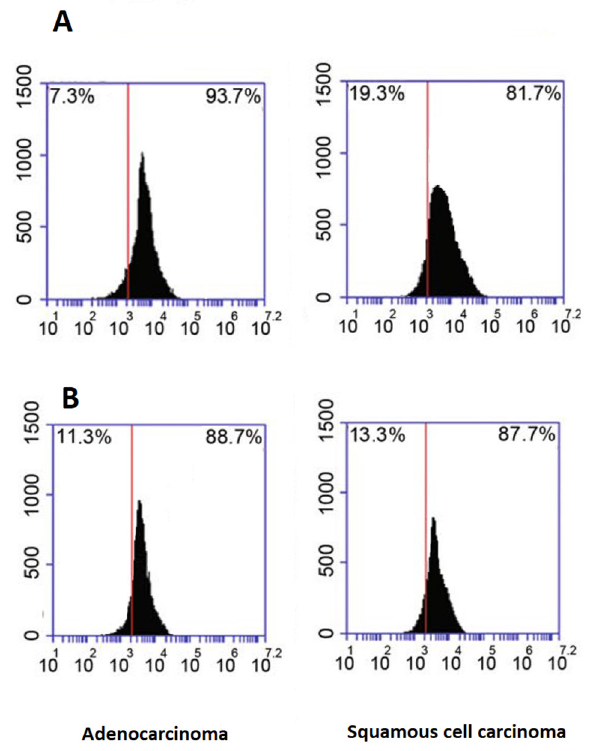
Figure 2. Flow cytometry results for the exosomal markers’ antibodies. Line ( A ): CD81; Line ( B ): CD63. Table 2. Characterization of EV particle diameter.